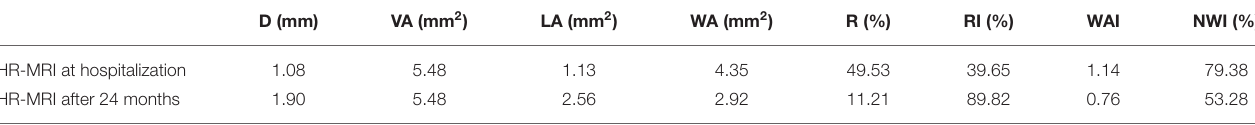
TABLE 1 | Changes of various indexes before and after follow-up. D (mm) VA (mm 2 ) LA (mm 2 )